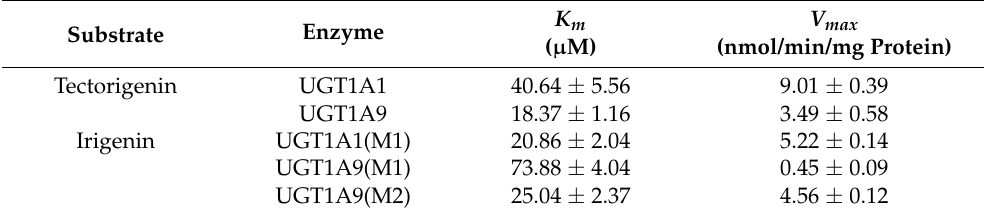
Table 3. Enzyme kinetic parameters of tectorigenin and irigenin glucuronidation (mean ± SE, n = 3). Substrate